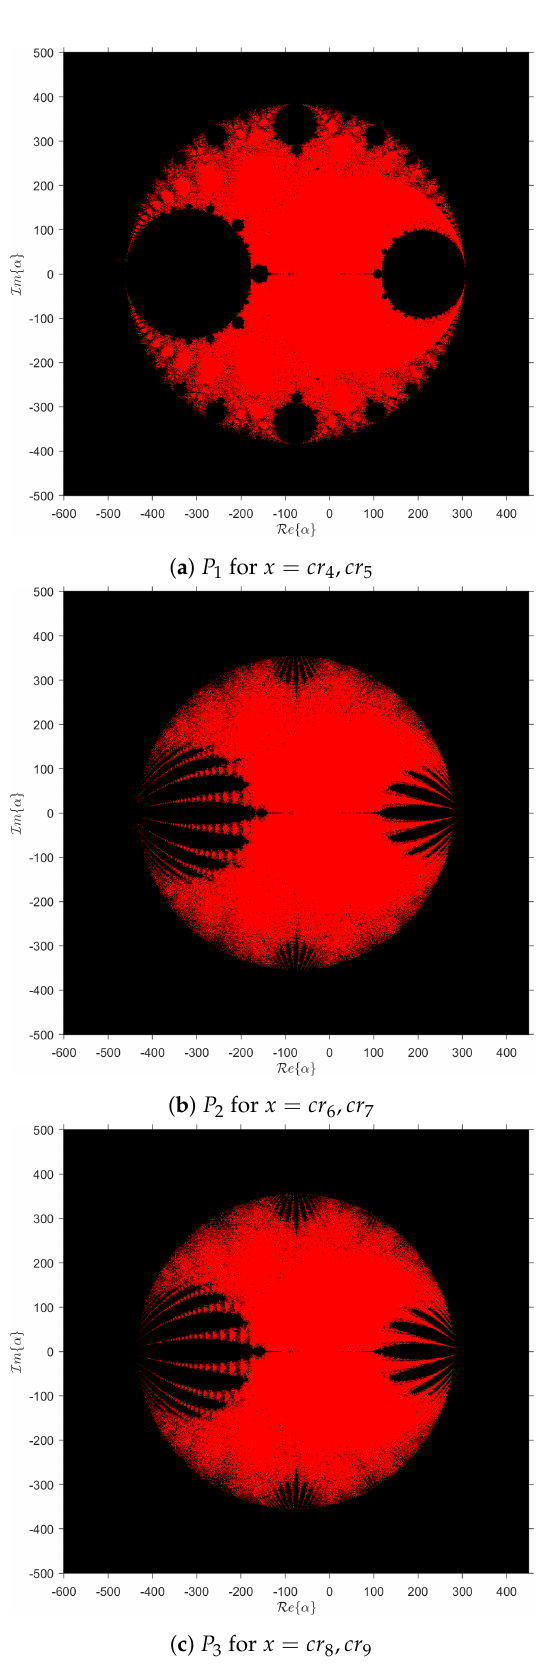
Figure 3. Parameter spaces of free critical points (in red color, the complex area where the corre- sponding critical point converges to 0 or ∞ , that is, the stability